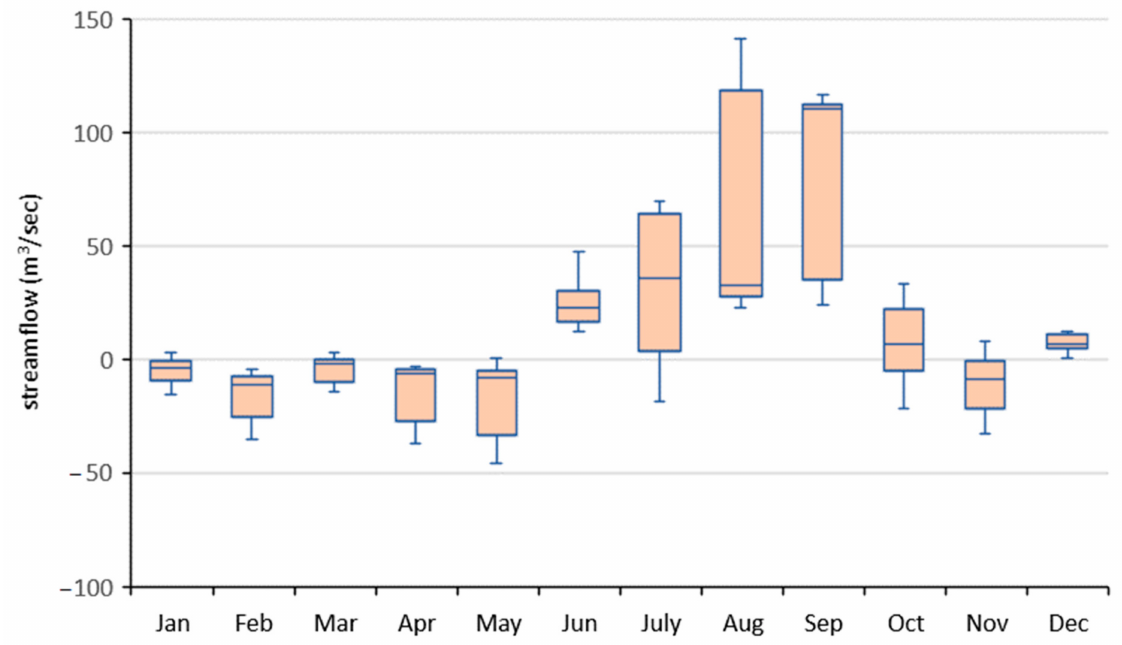
Figure 8. Excess/deficit water in the Babai River Basin under different sub-scenarios. Figure 8 was generated by using monthly data of the twenty sub-scenarios.